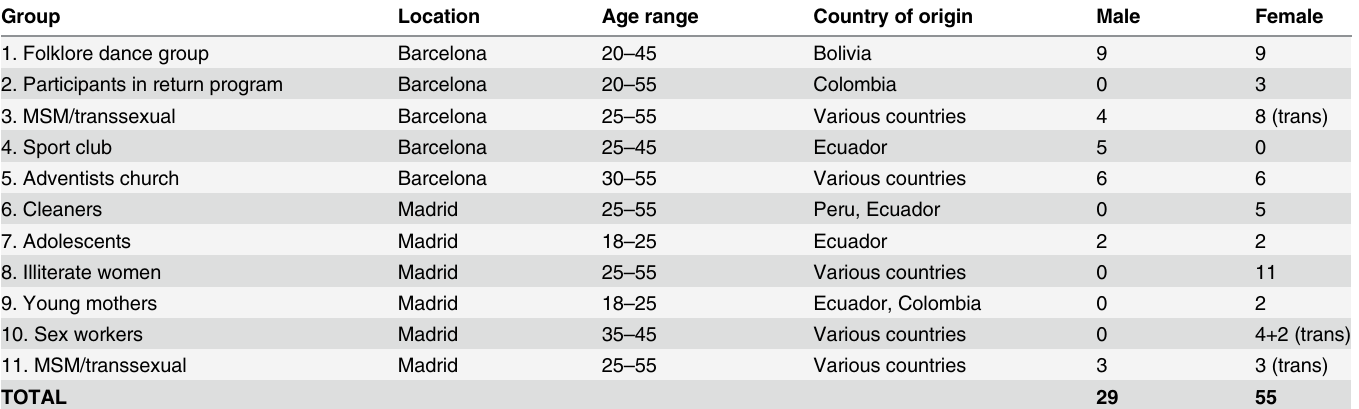
Table 1. Characteristics of study participants.